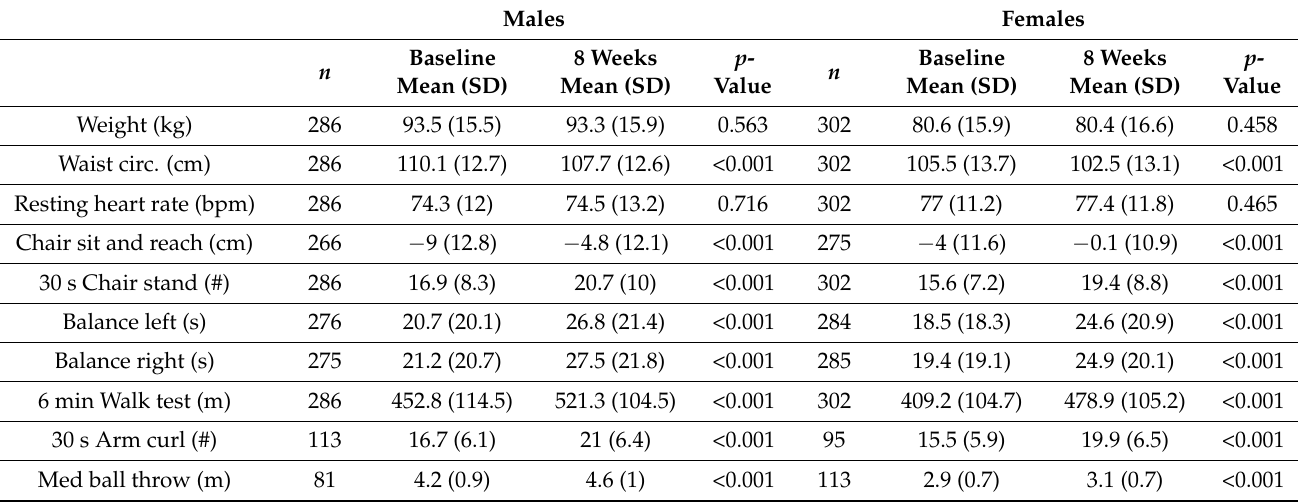
Table 2. Paired T-test for anthropometric and fitness measure changes from baseline to 8 weeks post